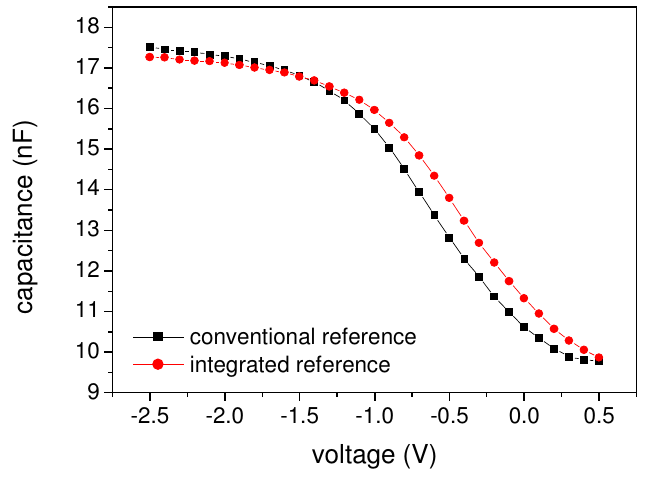
Figure 7. C/V curves of the system pH sensor/integrated reference electrode and pH sensor/conventional reference